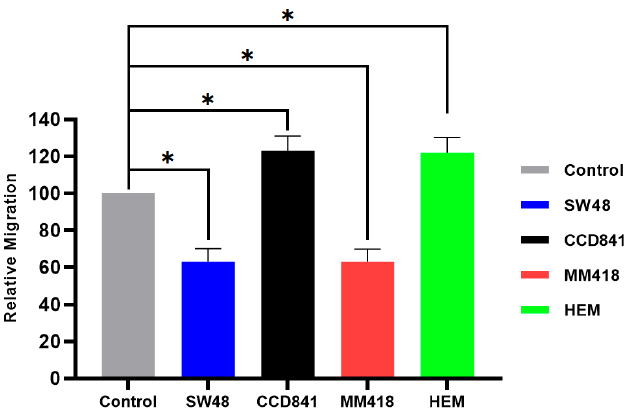
Figure 7. The effect of AuNPs + IR on the migration of human colon adenocarcinoma (SW48) and melanoma (MM418-C1) cell lines compared to their non-cancerous counterparts (CCD841 and HEM cells). The cells were irradiated with 5 Gy X-ray 24 h prior to the scratch test. Control represents the corresponding untreated cells in which the size of the gap closure over 24 h was expressed as 100%. Results were calculated as percentage of the corresponding untreated controls over that 24 h period and are expressed as the mean ± SEM of 3 replicates. Significance of different treatments compared to the untreated control is represented by black lines shown as * p < 0.05.